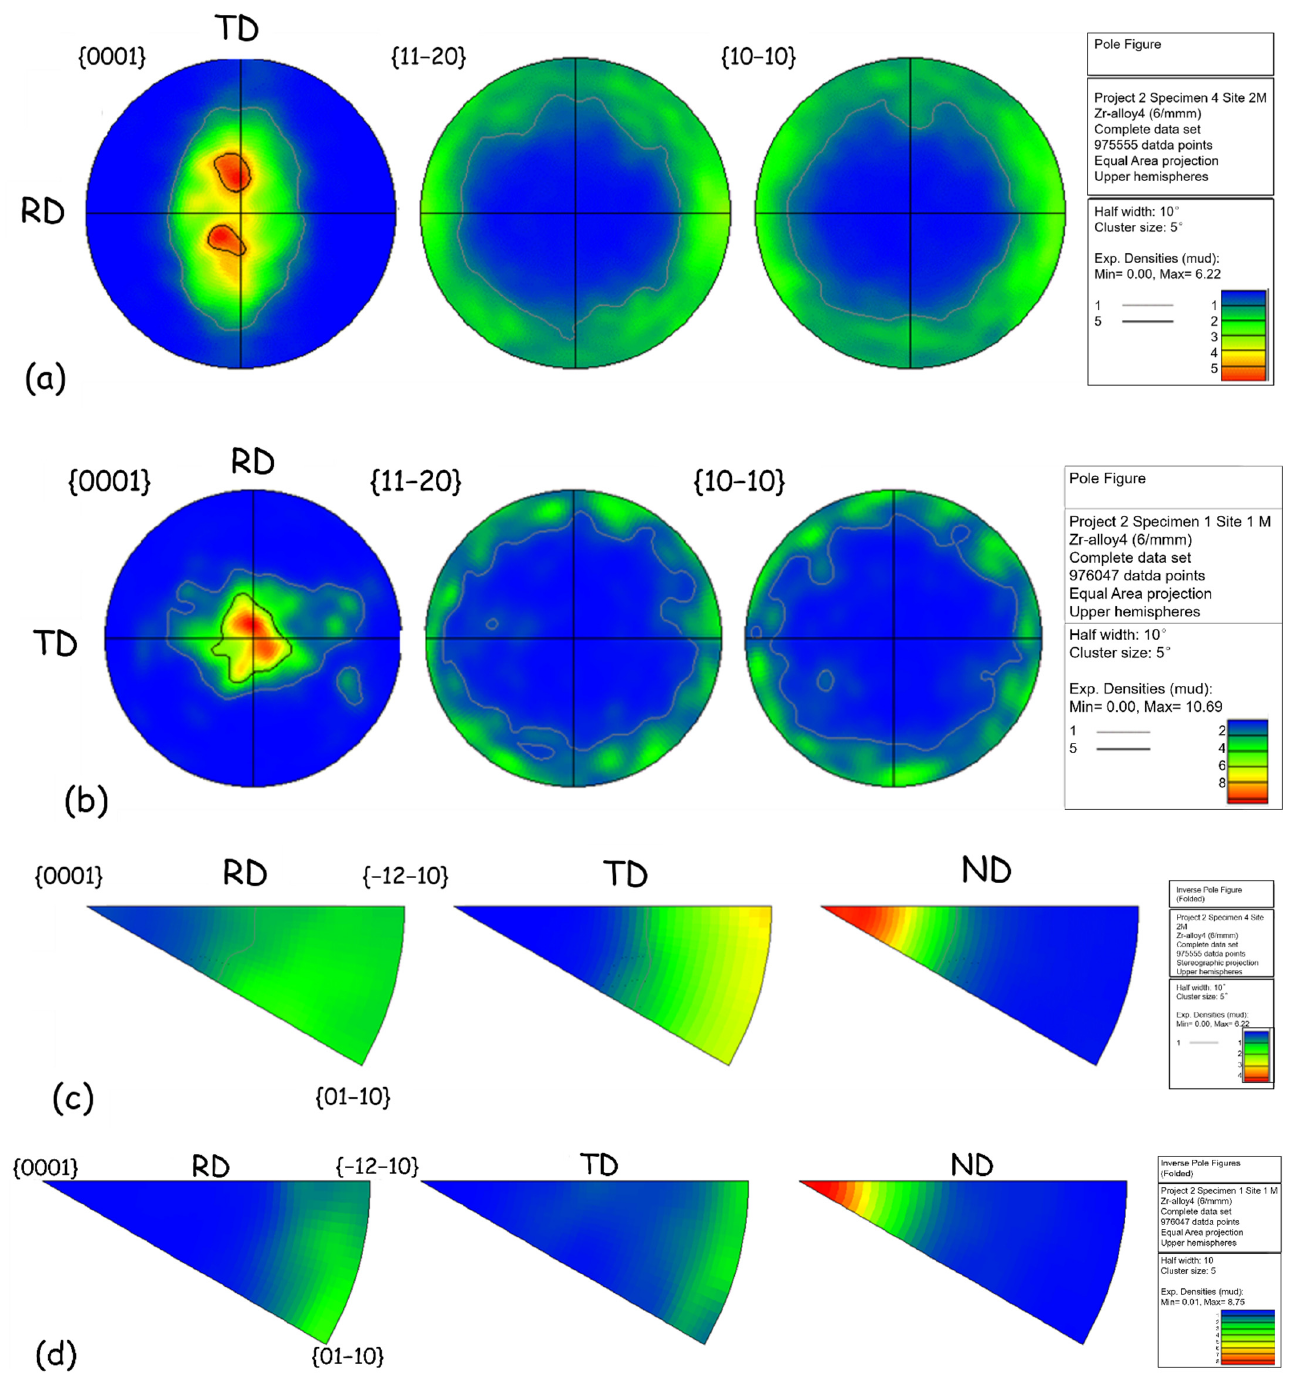
Figure 3. Pole figures of ( a ) original plates, ( c ) reprocessed plates and inverse pole figures of pole figure of ( b ) original plates and ( d ) reprocessed plates.